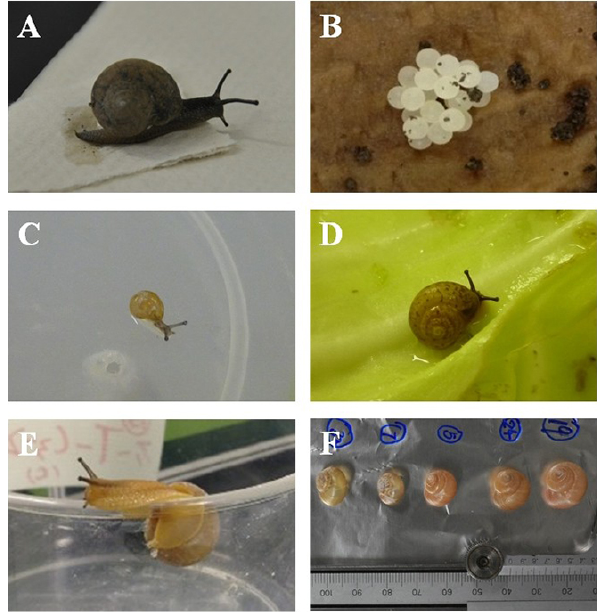
Figure 1. Growth phases of Acusta despecta sieboldiana : (a) adult snails collected from Suzukakedai, Yokohama, Japan (length: ca. 10–17mm); (b) eggs (ca. 2mm); (c) larva (1–3 days, ca. 2mm); (d) juvenile (3–4 months, ca. 5–8mm); (e) adult/juvenile (>6 months, >10mm); (f) shells used for isotopic